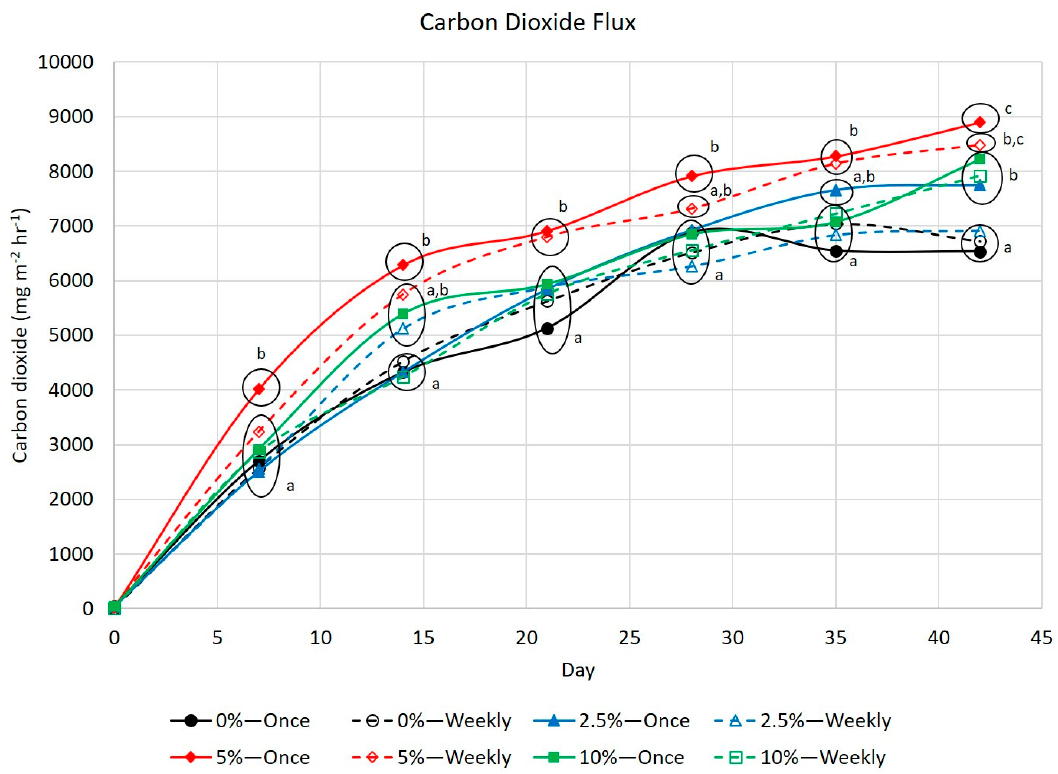
Figure 2. Average carbon dioxide flux (mg m − 2 h − 1 ) for weekly measurements taken over 42 days for bedded packs treated with 0, 2.5, 5, and 10% alum, either in one dose or in weekly doses. Alum × Dose × Day interaction p < 0.01, Pooled standard error of the mean = 154.3. Clusters with different letters indicate significant differences p < 0.05 .